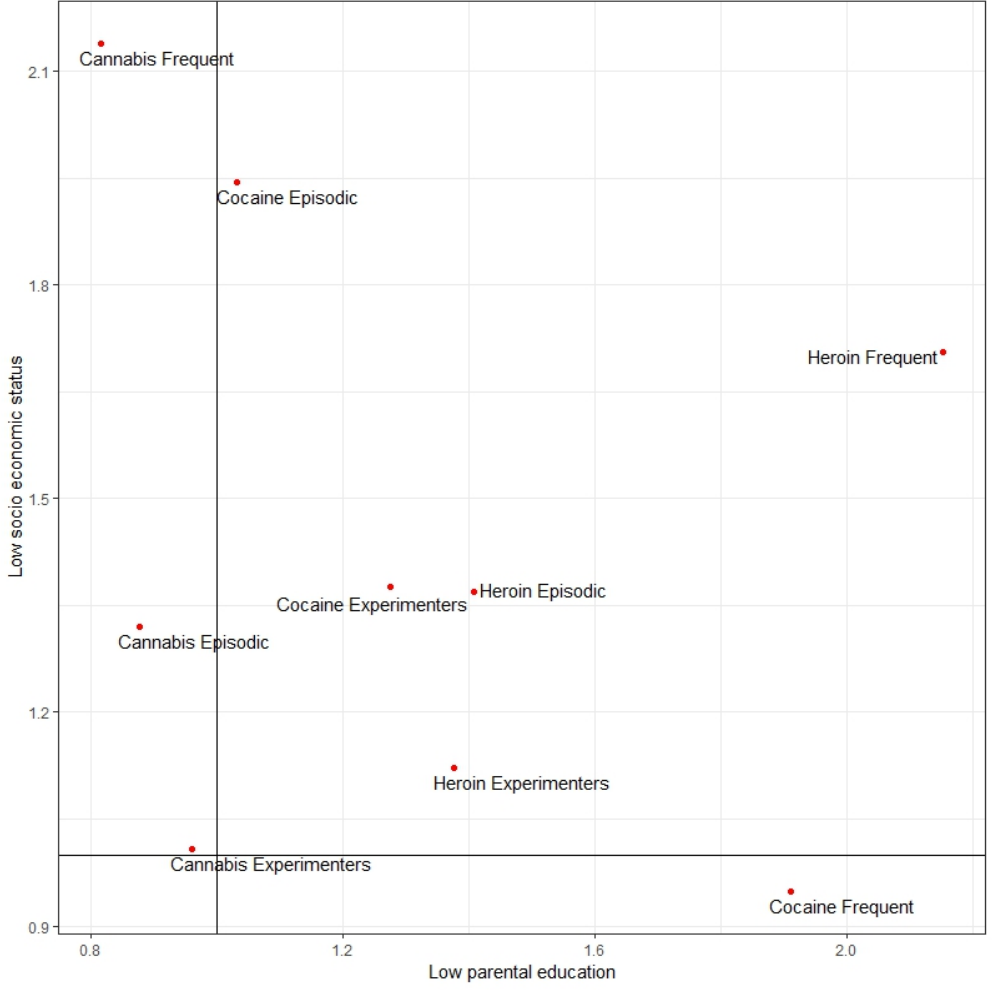
Figure 5. Quadrant analysis with adjusted Odds Ratios (aOR) for low socioeconomic status and low parental education with model B. Authors’ elaboration on ESPAD data. Note: upper right quadrant = low socioeconomic status and low parental education; bottom right quadrant = high socioeconomic status and low parental education; bottom left quadrant = high socioeconomic status and high parental education; upper left quadrant = low socioeconomic status and high parental education.